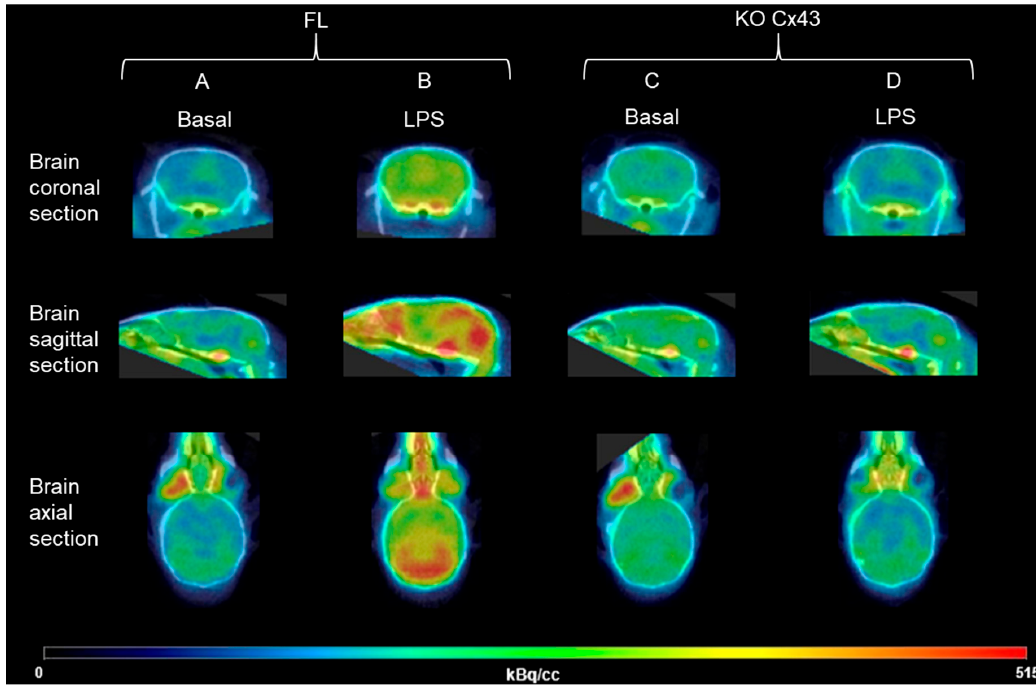
Figure 3. Representative microPET/CT imaging of brain inflammation with the TSPO radioligand